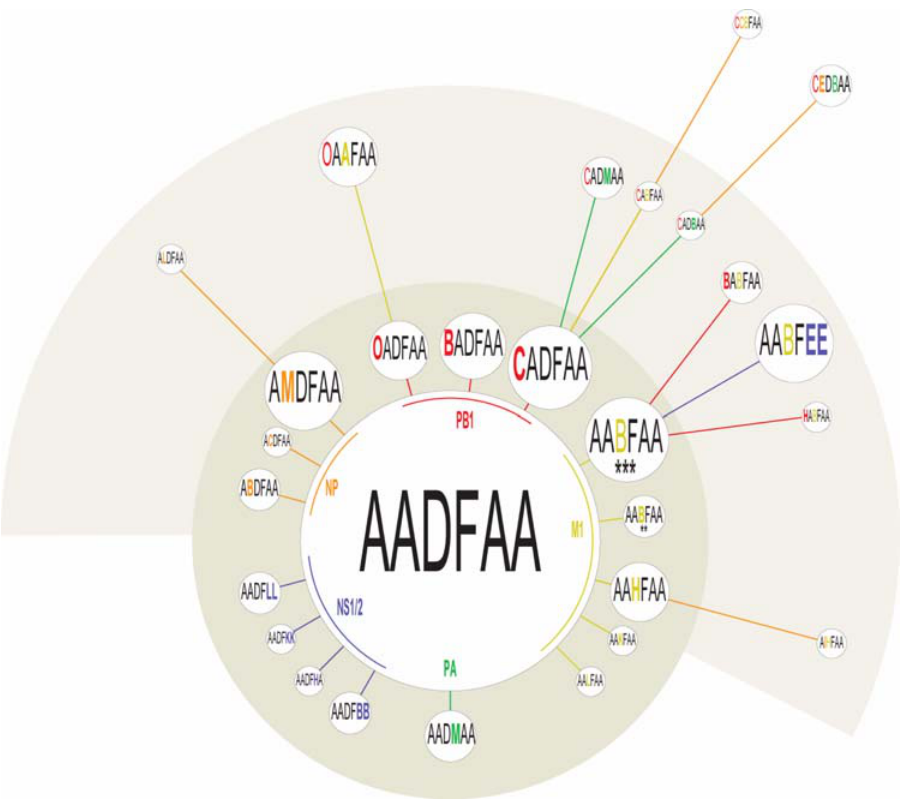
Figure 4. Relationship of founder isolate AADFAA and closest descendents in the 2005–2006 season. The areas of the circles are scaled to the number of human samples that contained the BC-types. Each concentric ring represents a single, double and triple mutations removed from the founder isolate, color coded for the gene containing the mutation. The order of the letters in the BC-type correspond to the six primer pairs used in this study, targeting PB1, NP, PA, M1, NS1 and NS2,